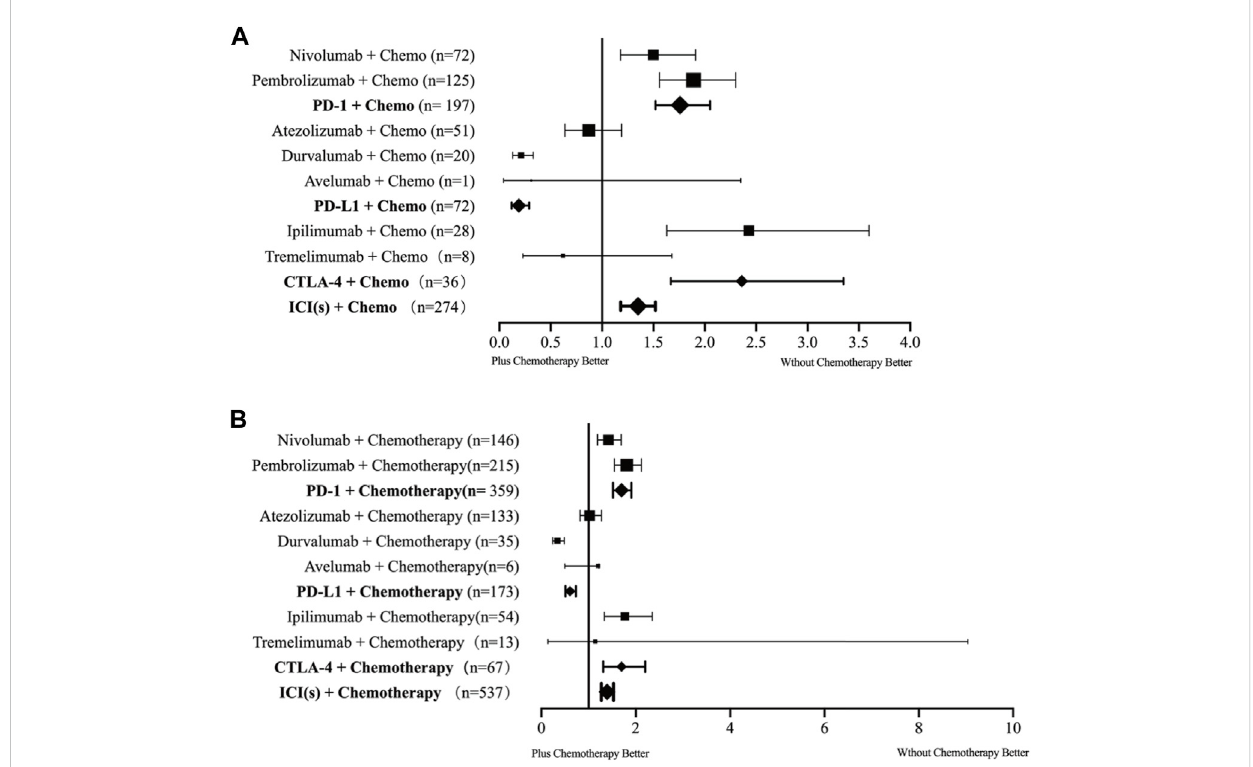
FIGURE 3 Forest plotoftheincidence ratesofcheckpointinhibitorpneumonitisfor eachtypeofcombinationtherapy. (A) datafromtheVigiBase database. (B) data from the FAERS database. Chemo: chemotherapy; ICI: immune checkpoint inhibitor; PD-1: programmed cell death receptor 1 inhibitors; PD-L1: programmed cell death ligand 1 inhibitors; CTLA4: cytotoxic T lymphocyte antigen 4